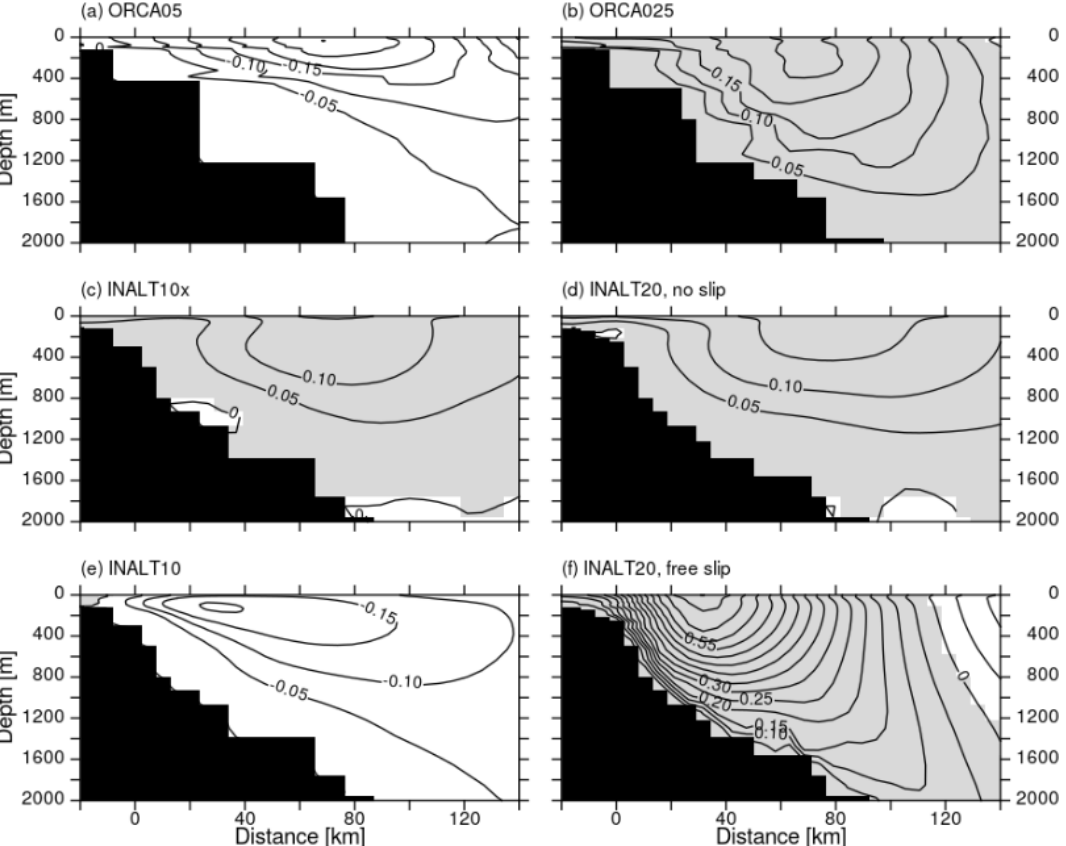
Figure 9. Mean (2000–2009) MC structure at 41 ◦ S from ORCA05 (a) , ORCA025 (b) , INALT10x (c) , INALT20 NS_RW (d) , INALT10 (e) and INALT20 FS_RW (f) . Note that southwestward/negative velocities are shaded in white and northeastward/positive in grey; contoured are intervals of 5cms − 1 .